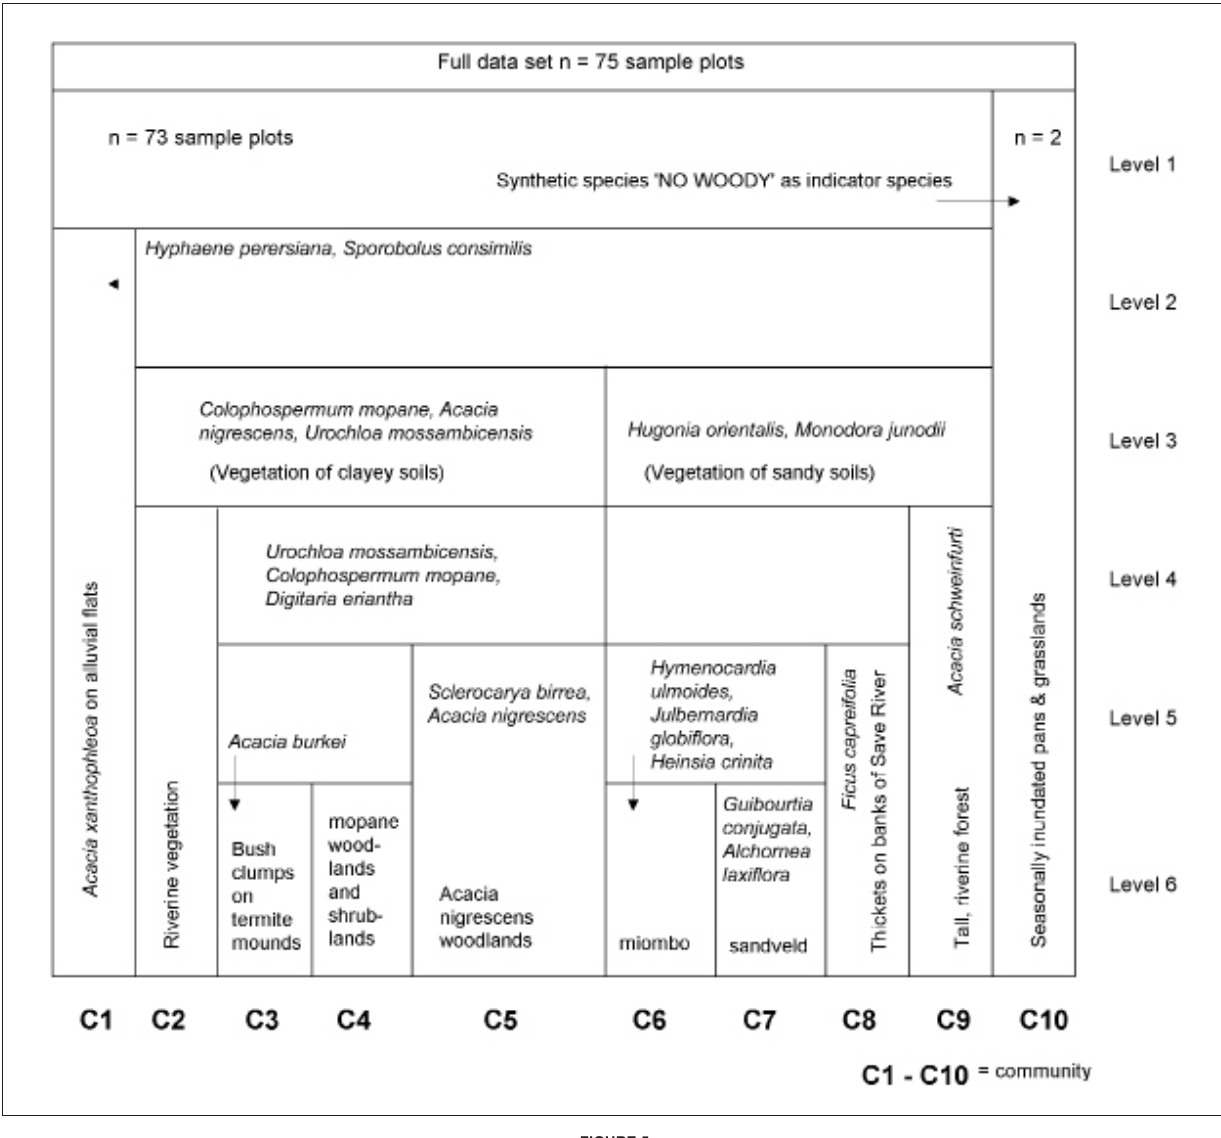
FIGURE 5 Hierarchical representation of the vegetation communities in the Parque Nacional de Zinave, where Levels 1 to 6 indicate increasing levels of homogeneity and specific composition and indicator species, as illustrated by the TWINSPAN classification, are underlined; communities that split off at an early level indicate a very distinctive and different assemblage from other